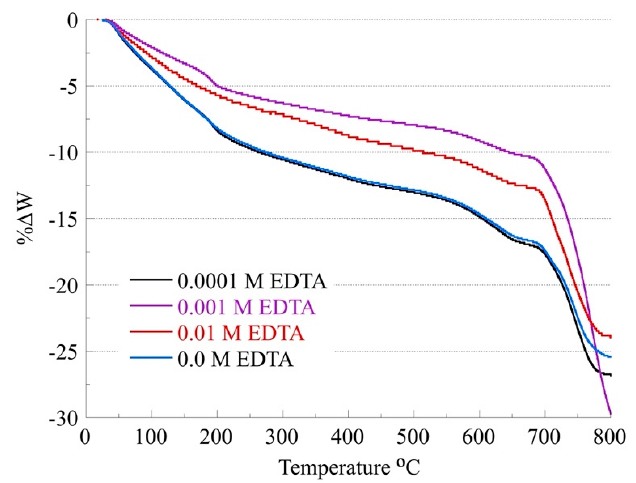
Figure 6. Thermograms of C-S-H solid phases, which were in contact with aqueous solution of varying EDTA concentration for 30 days.